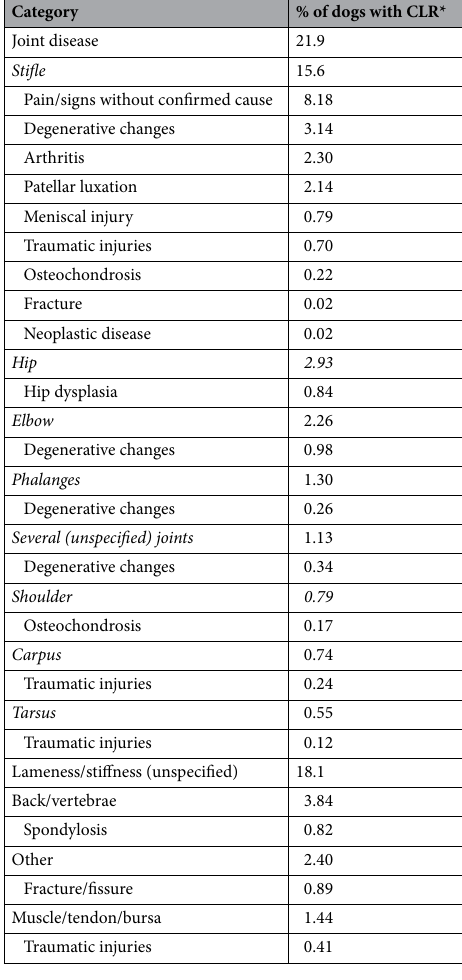
Table 4. Previous musculoskeletal diagnoses in dogs with veterinary care claims for cruciate ligament rupture (CLR) in Agria Pet insurance (2011–2016). *In total 4167 dogs with veterinary care claims for CLR. All subcategories for stifle joint diagnoses are presented. For all other categories the most specific subcategory is presented, even though pain/signs without confirmed cause was generally the most common subcategory.